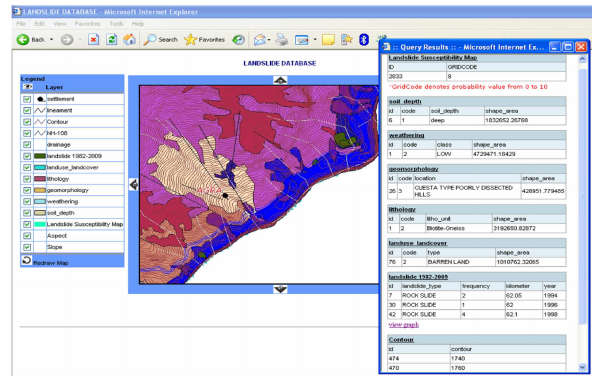
Figure 6. Dynamic web enabled Query window showing various geoenvironmental layers fetched from spatially enabled PostgreSQL database